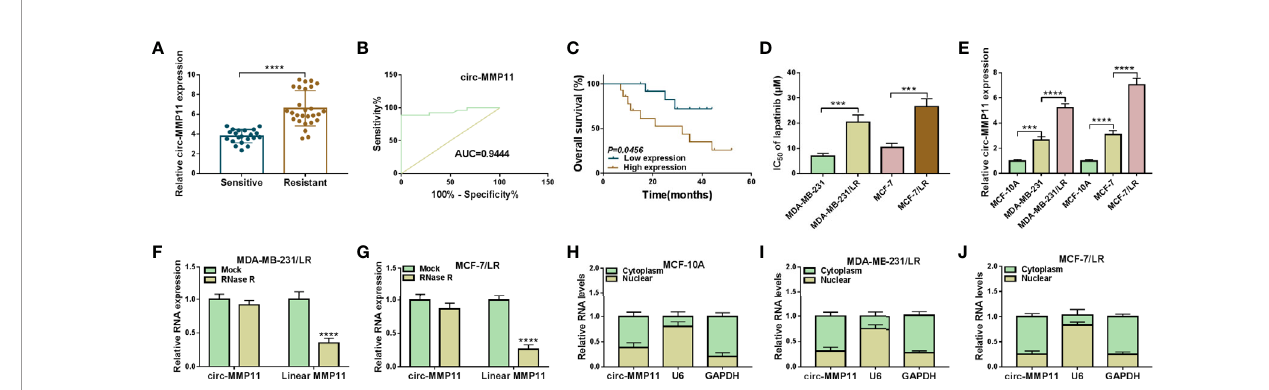
FIGURE 1 | Expression patterns of circ-MMP11 in LR breast cancer tissues and cells. (A) RT-qPCR assay was applied to assess the expression level of circ- MMP11 in the drug-sensitive group (n = 21) and the drug-resistant group (n = 27). (B) ROC curve analysis for the diagnostic value evaluation of circ-MMP11 in breast cancer patients. (C) The overall survival of breast cancer patients with circ-MMP11 high or low level was determined by Kaplan – Meier analysis. (D) MTT assay was used to analyze the IC 50 value of lapatinib in breast cancer cell lines (MDA-MB-231 and MCF-7), and LR-resistant breast cancer cell lines (MDA-MB-231/LR and MCF-7/LR cells). (E) Relative circ-MMP11 expression was detected in MCF-10A, MDA-MB-231, MDA-MB-231/LR, MCF-7, MCF-7/LR cells. (F, G) Expression levels of circ-MMP11 and linear MMP11 were examined in MDA-MB-231/LR and MCF-7/LR cells treated with RNase R or Mock. (H – J) The cellular localization of circ- MMP11 in MCF-10A cells and LR breast cancer cells was analyzed by Subcellular fractionation assay. *** P < 0.001, **** P < 0.0001 (Student ’ s t -test or ANOVA with Tukey ’ s tests), circ-MMP11 relative to